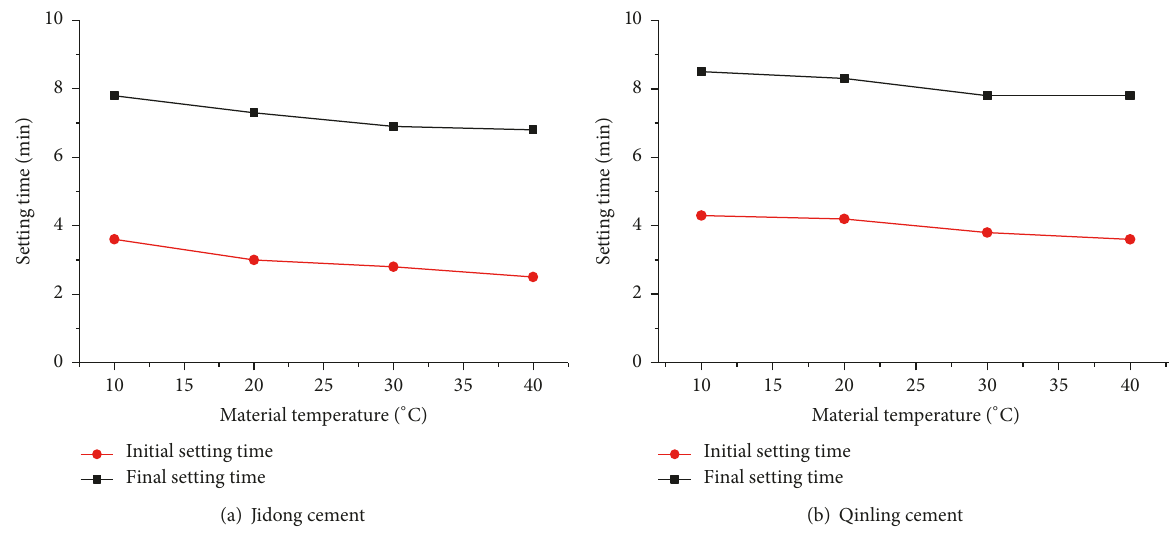
Figure 3: The effect of temperature on setting time of cement